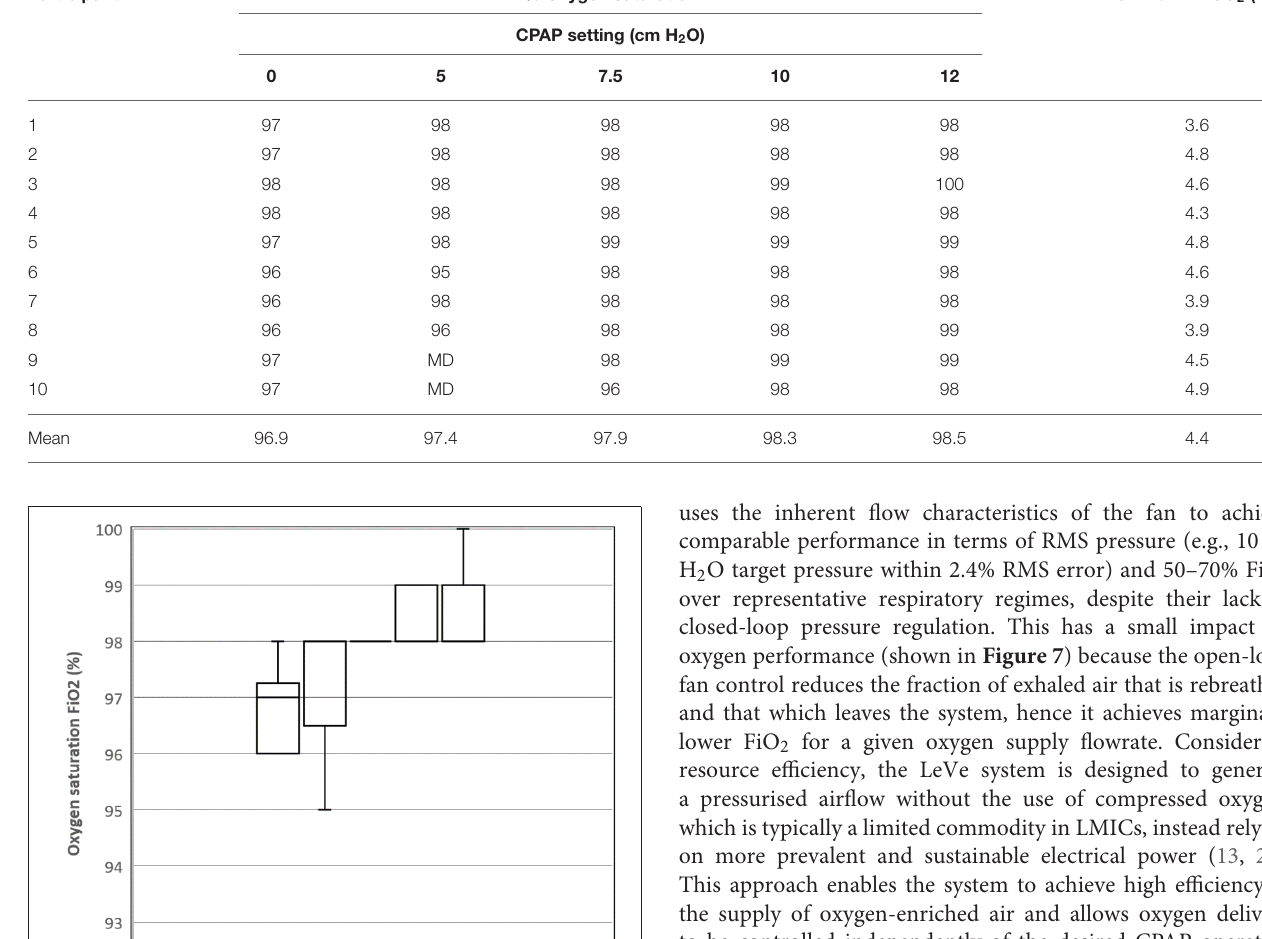
TABLE 2 | Oxygen saturation and end-tidal CO 2 levels across the cohort (MD, Missing data due to reading error). Participant % Oxygen saturation